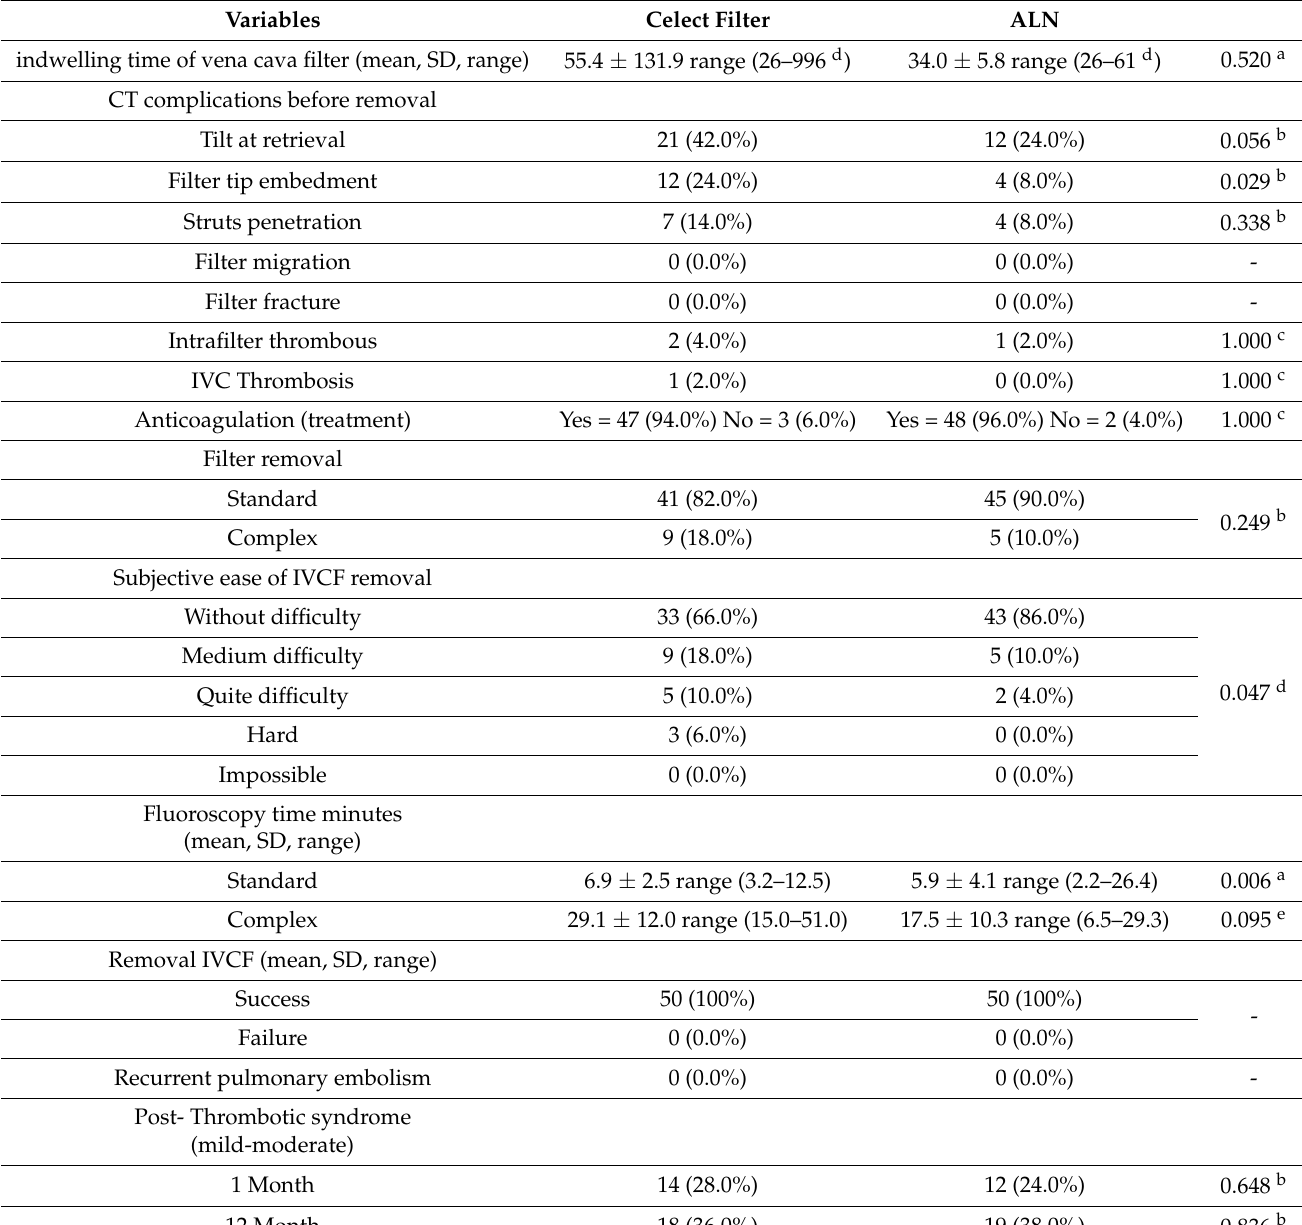
Table 3. Filter retrieval data and some